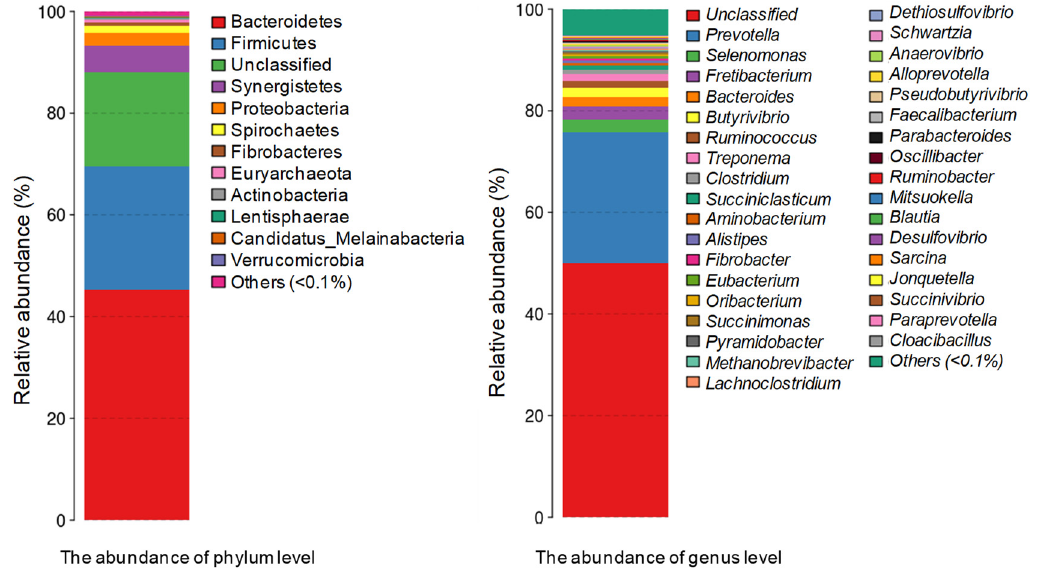
Figure 1. The distribution of taxonomic composition histograms at phylum and genus levels of bacterial community in Co and Bach Thao goats’ rumen.